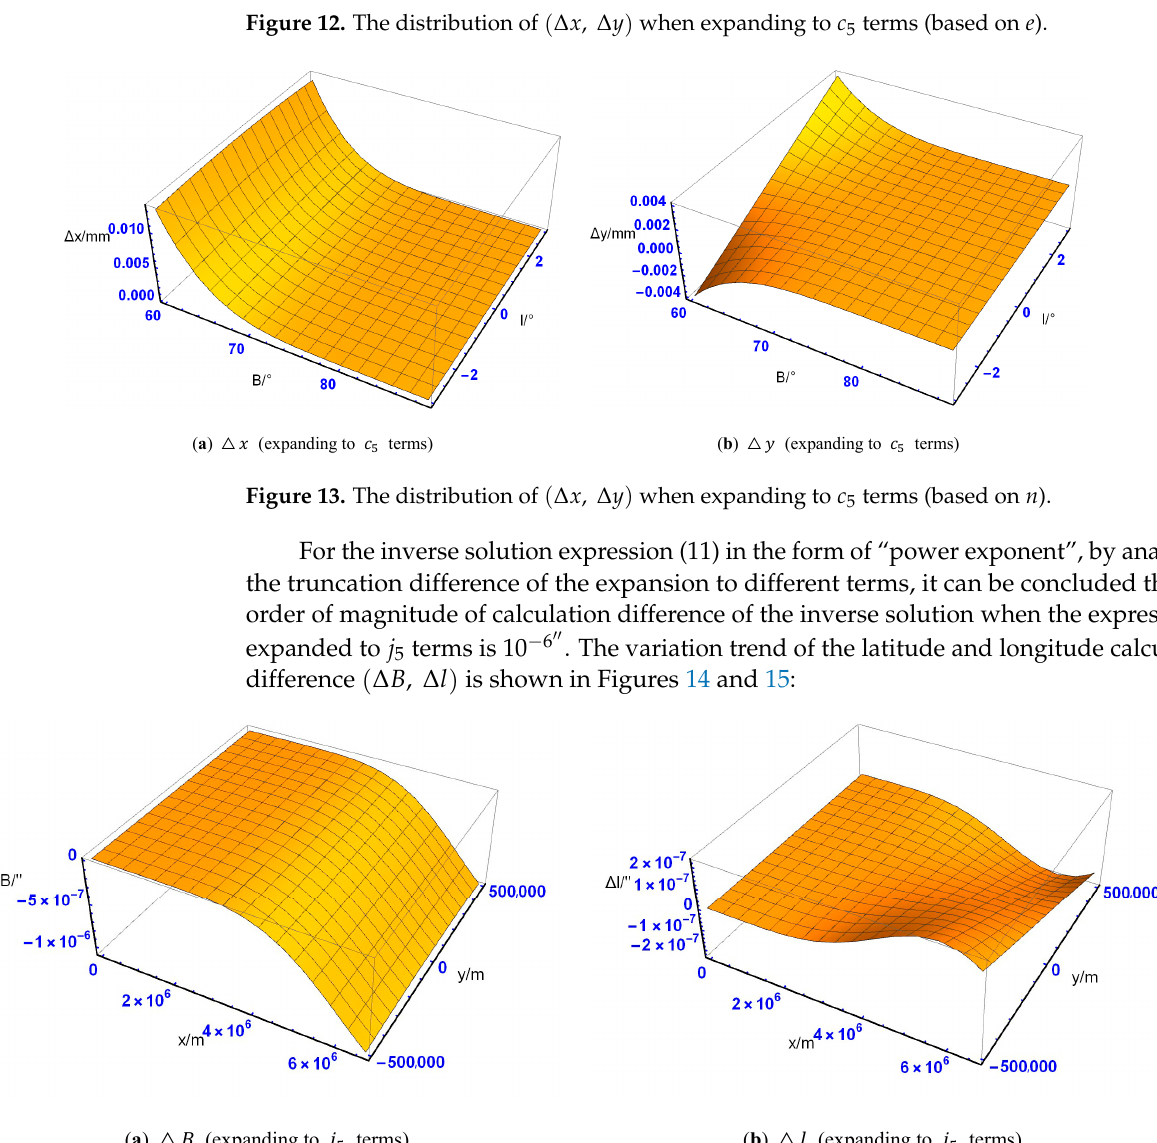
Figure 14. The distribution of (△ 𝐵,△ 𝑙) when expanding to 𝑗 (cid:2873) terms (based on 𝑒 ).